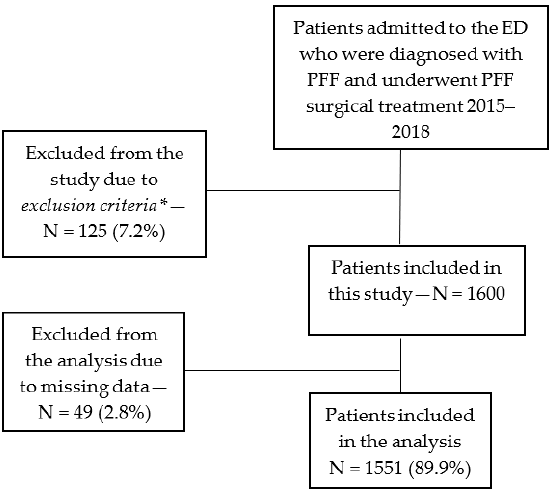
Figure 1. Study population flowchart (inclusion and exclusion). * Exclusion criteria: patients diag- nosed with pathological fracture, younger than age 65 years at admission or after recent chemotherapy, radiotherapy, or steroid therapy.